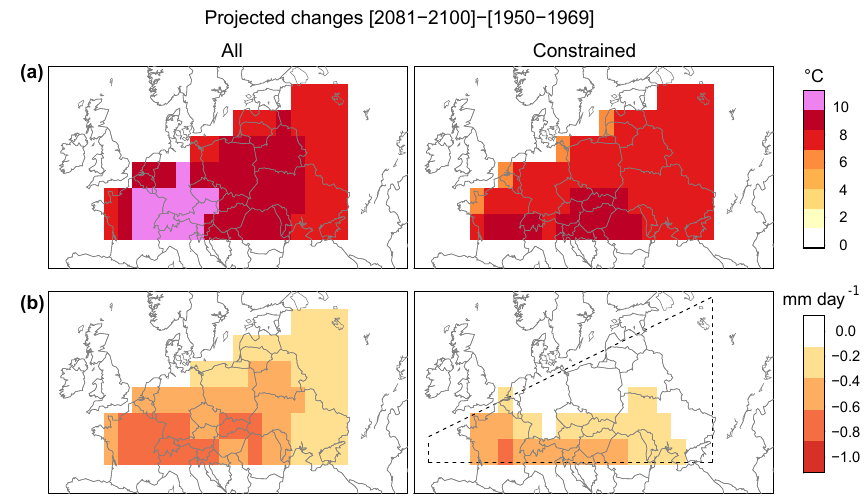
Figure 7. Future vs. present-day (a) TXx and (b) summer precipitation of the multi-model mean from the full (left) and the constrained (right)